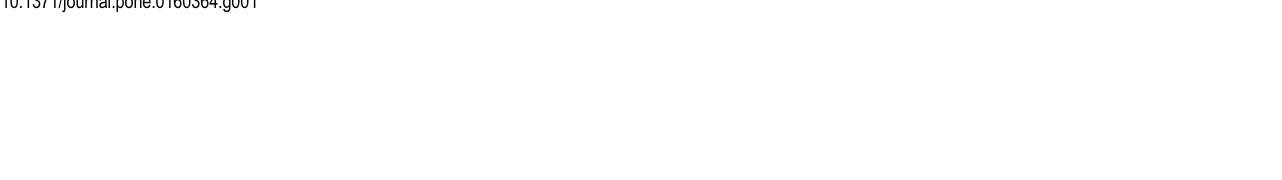
PLOS ONE | DOI:10.1371/journal.pone.0160364 July 29,